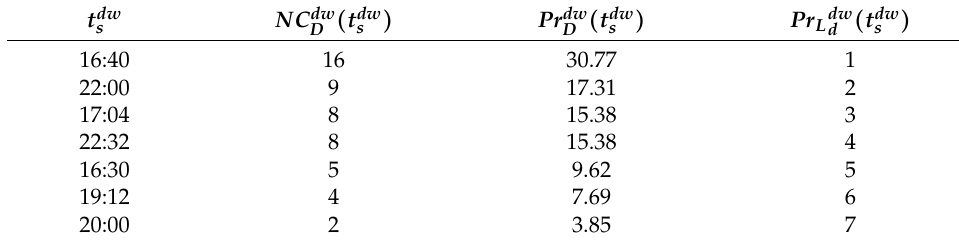
Table 5. Priority level values for t dw s for Scenario 1.